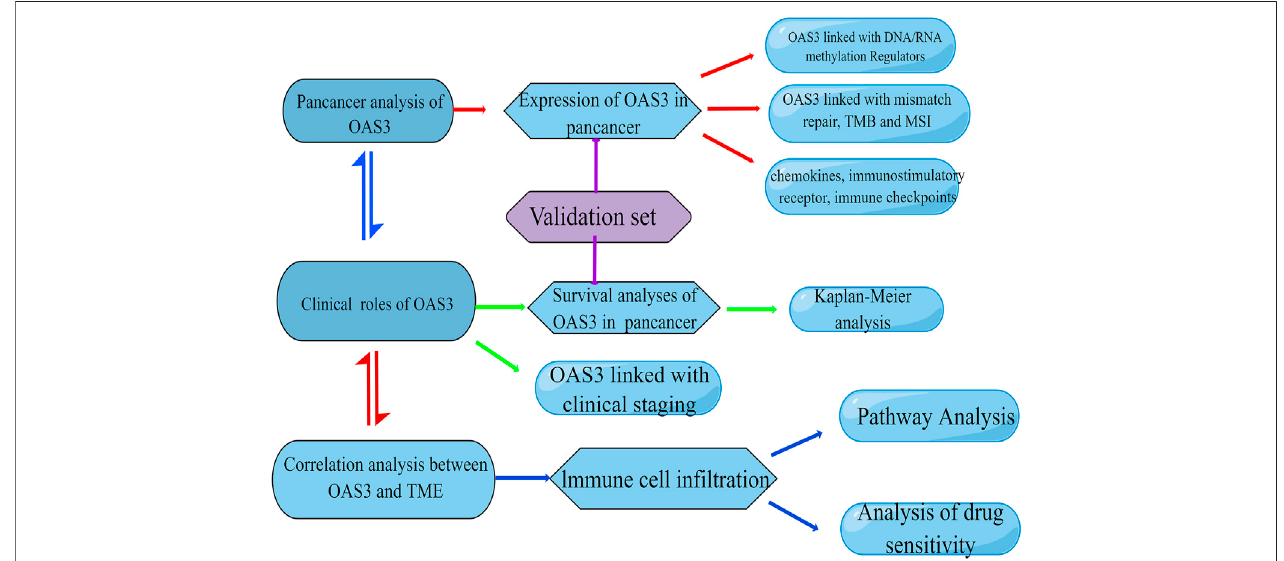
FIGURE 1 | Flowchart of the study. This image was drawn by Figdraw (www. fi gdraw.com).